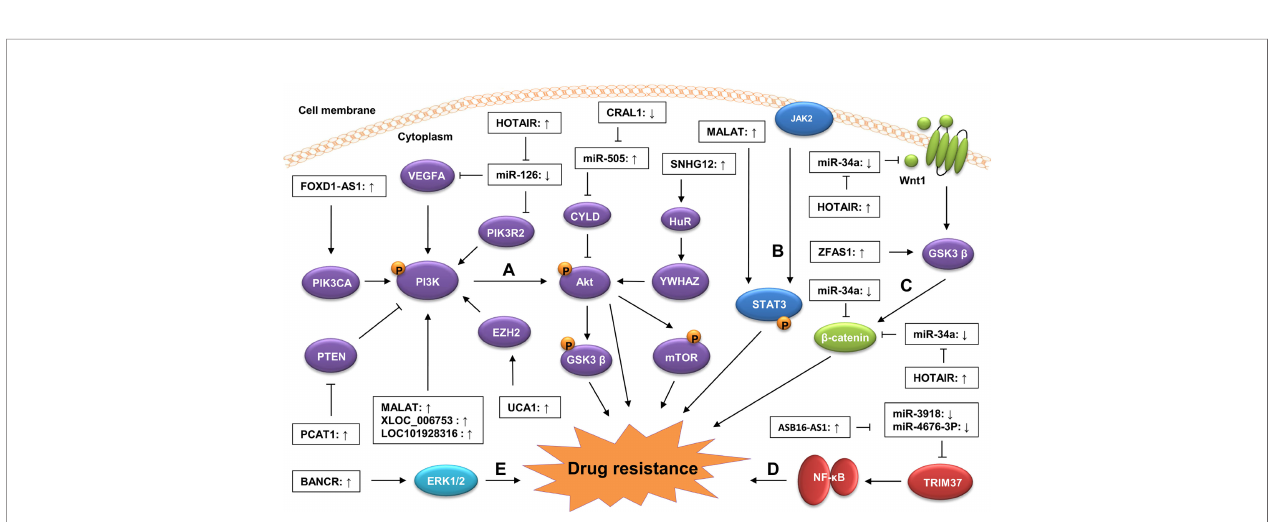
FIGURE 2 | Regulation of lncRNAs on signaling pathways in GC drug resistance. Dysregulated lncRNAs contribute to GC drug resistance by targeting oncogenic signaling pathways, including the PI3K/AKT (A) , STAT3 (B) , Wnt/ b -catenin (C) , NF-kB (D) , and (E) MAPK/ERK signaling pathways. Generally, the dysregulated lncRNAs can activate oncogenic signaling pathways by modulating the expression of key components in these signaling pathways via sponging miRNAs. They also can in fl uence these signaling pathways by altering the modi fi cation of their key components via regulating the activity of upstream regulators.